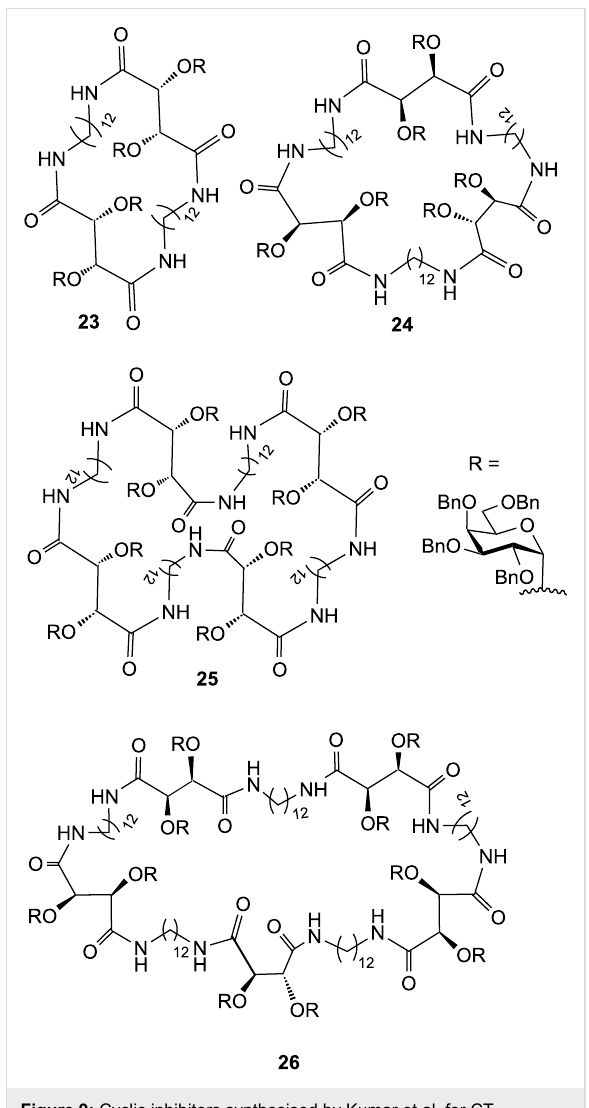
Figure 9: Cyclic inhibitors synthesised by Kumar et al. for CT.